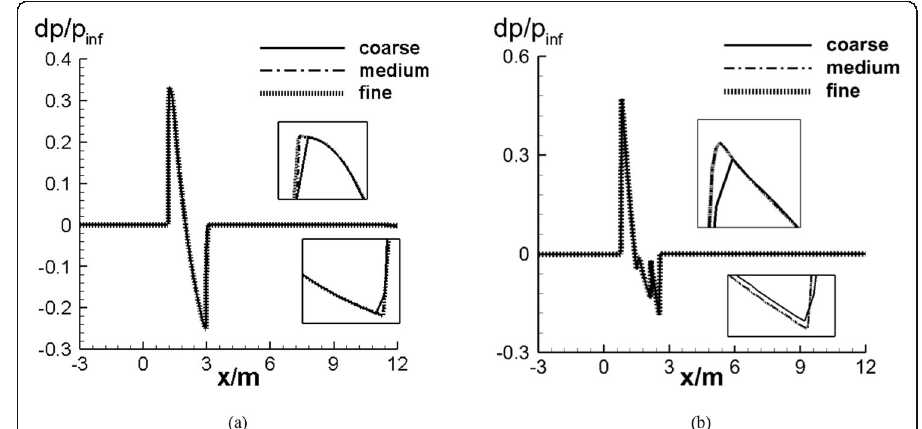
Table 1 Aerodynamic coefficients and the corresponding error of diamond airfoil by using different methods α Cd Cl / o CFD Theoretical method Error / % CFD technology 0